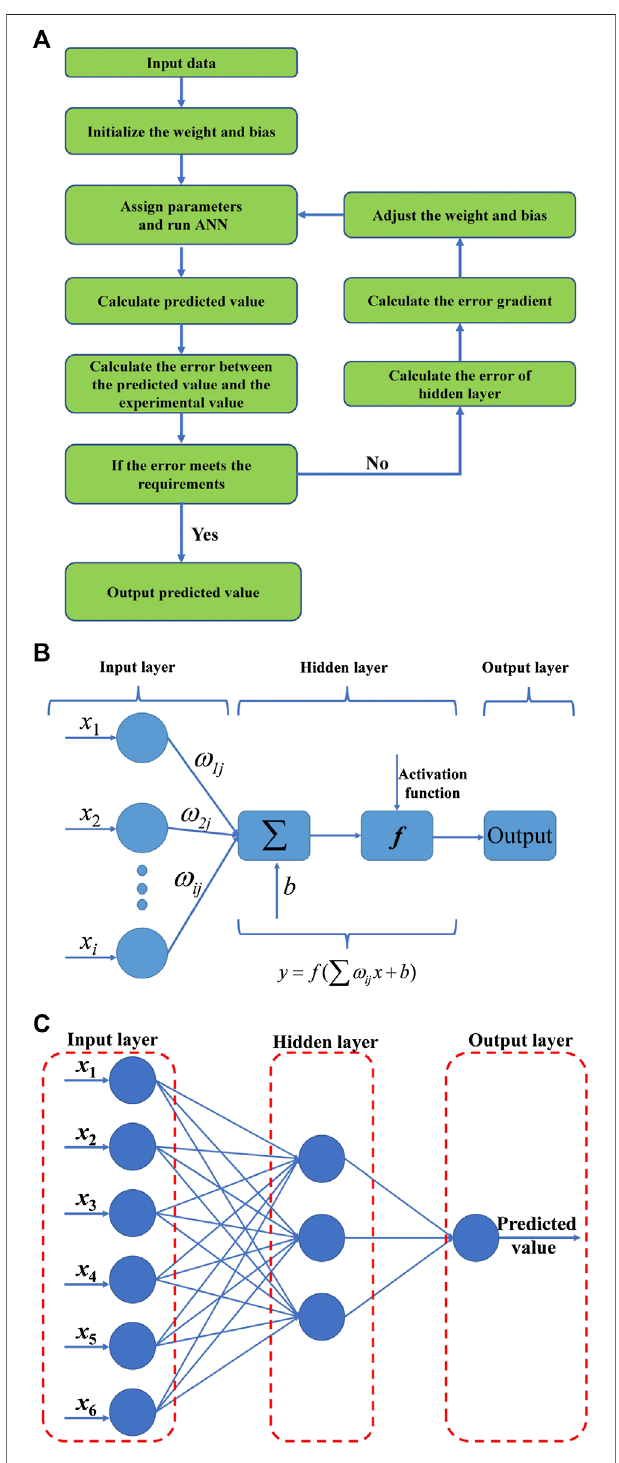
FIGURE 2 | The process and models of ANN. (A) the process of ANN, (B) a typical neuron Model, (C) the ANN model used in the test.